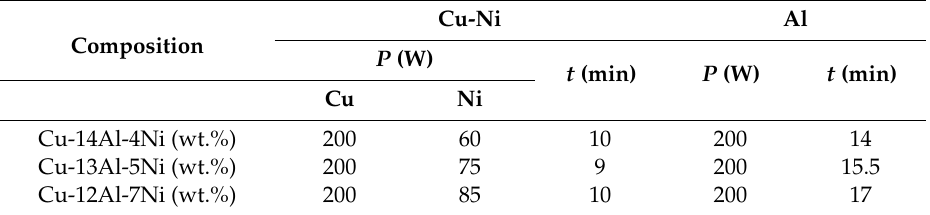
Table 2. The power (W) and time (min) conditions applied for the sputtering of samples Cu–14Al–4Ni (wt.%), Cu–13Al–5Ni (wt.%), and Cu–12Al–7Ni (wt.%).